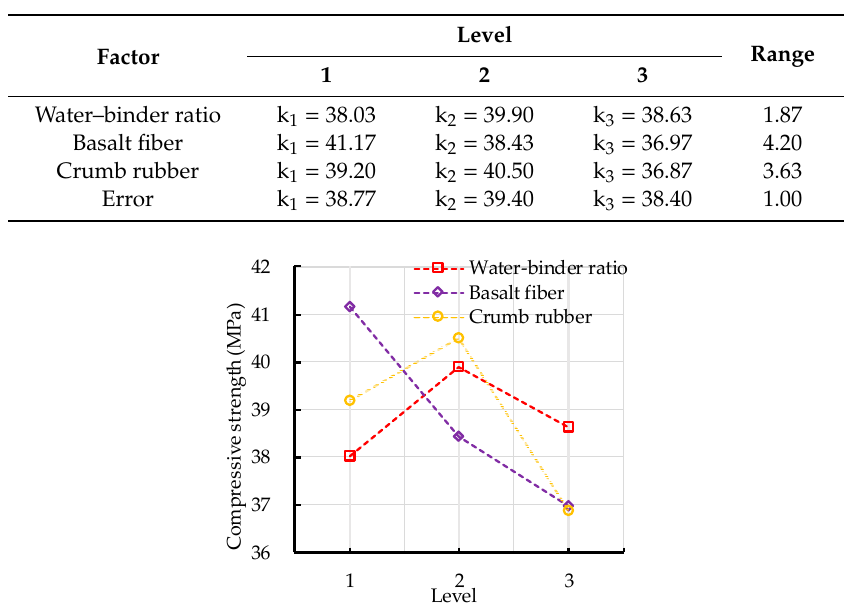
Figure 5. Effects of water–binder ratio, basalt fiber content and crumb rubber replacement rate on the compressive strength of CRBFC.